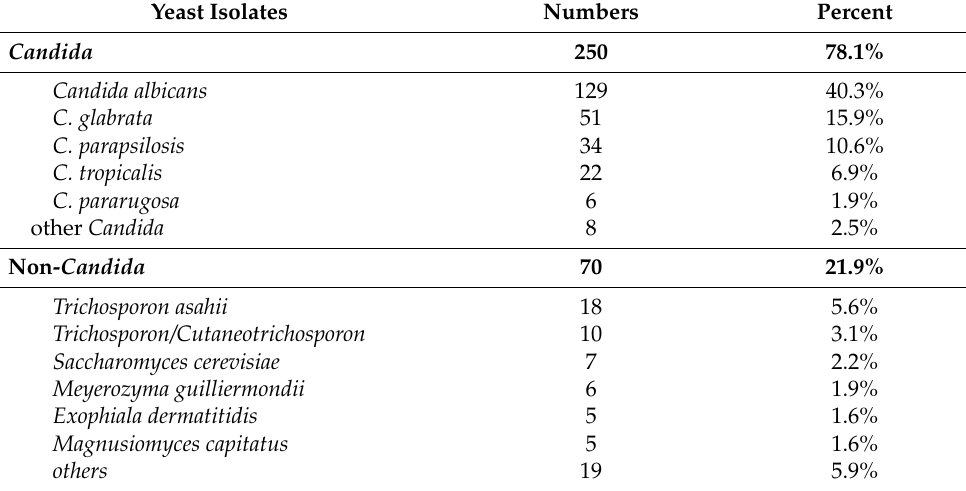
Figure 2. Distribution of commensal oral yeasts in the residents of nursing homes. All identified yeasts were grouped together into taxa and sorted according to population size ( A ). The yeast isolates in the group “Others” do not belong to the genus Candida or Trichosporon/Cutaneotrichosporon . Details are shown in ( B ). Table 1. List of isolated